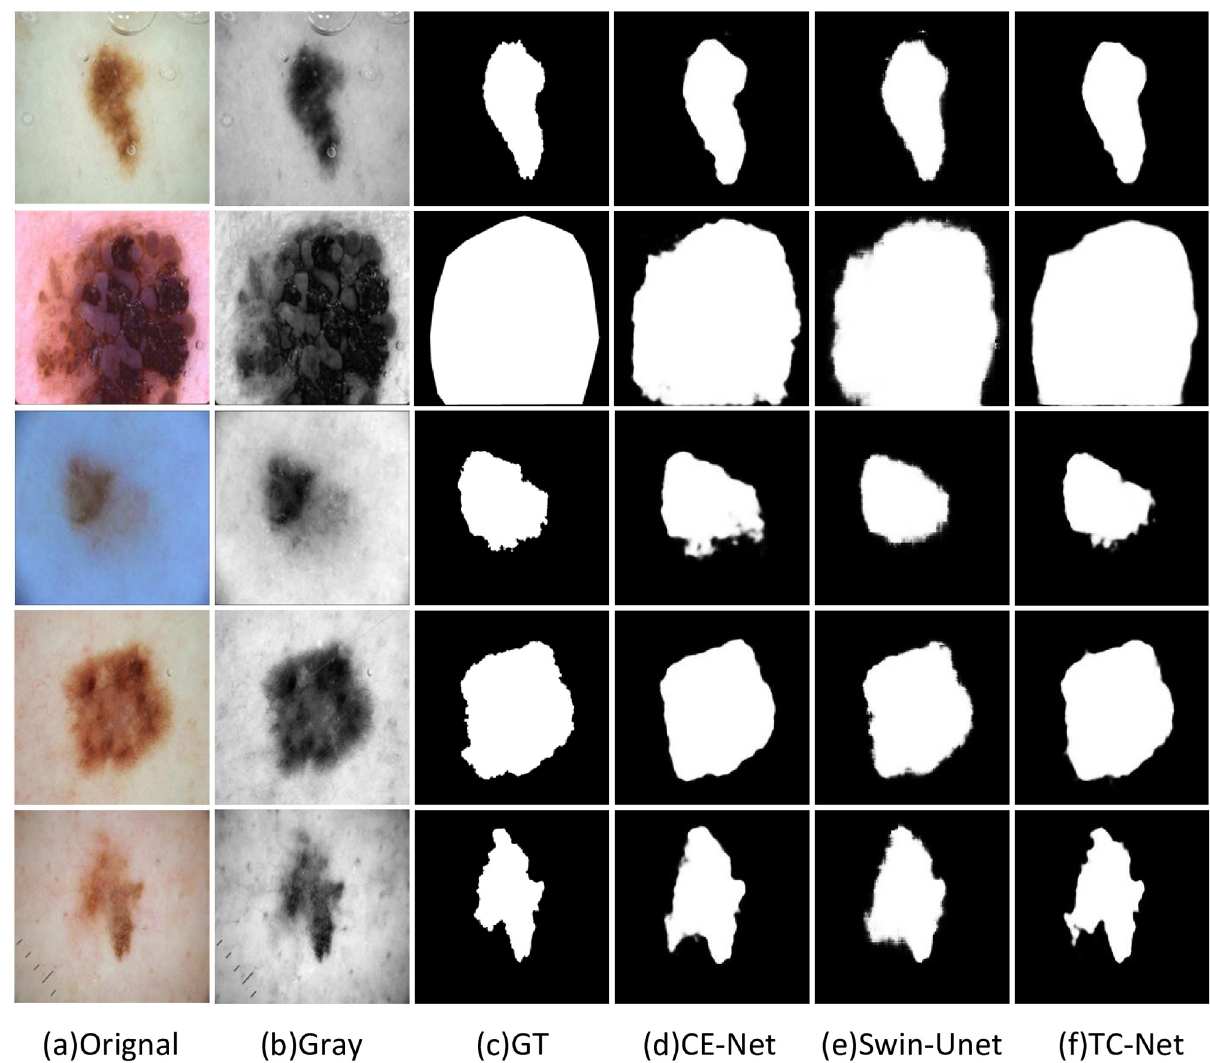
Fig 6. The example on ISIC2018 dataset, (a) original image; (b) Gray image; (c) GT label image; (d) Segmentation image of CE-Net; (e) Segmentation image of Swin-UNet; (f) Segmentation image of TC-Net.